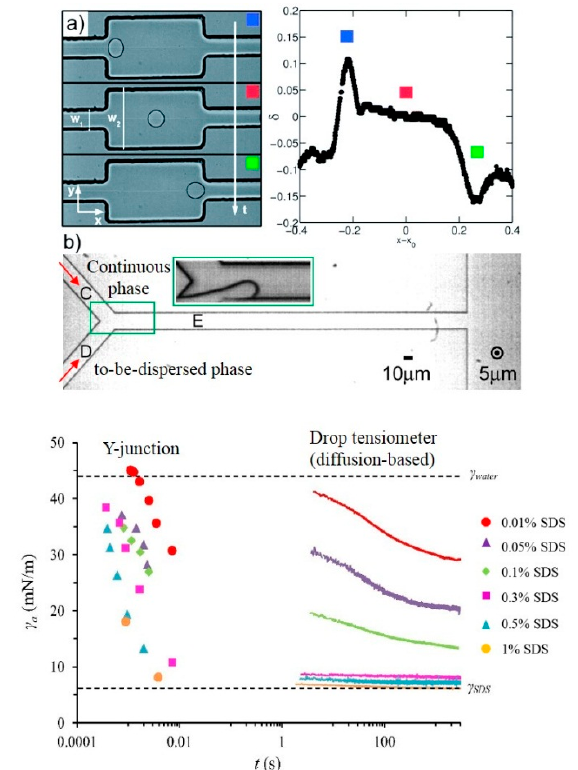
Figure 7. ( a ) Left: Diagram of the expansion cell; Right: The typical deformation ( δ ) of a droplet flowing in the expansion cell, reproduced from Brosseau et al. (2014) [62] by permission from the Royal Society of Chemistry. From the top (left) to the bottom (right), three important deformation points were indicated with different color squares: The droplet just enters the expansion, the elongated droplet relaxes back to a sphere, and it enters the next constriction. ( b ) Top: Layout of a microfluidic Y-junction with an angle of 97° between channel C and D [55], adapted with permission from the American Chemical Society; Bottom: The dynamic interfacial tension for hexadecane/SDS solution of different concentrations, derived by using Y-junction as a function of droplet formation time. As a comparison, the interfacial tension obtained with a droplet volume tensiometer is given on the right. Reprinted from Muijlwijk et al. (2016) [65], with permission from Elsevier.